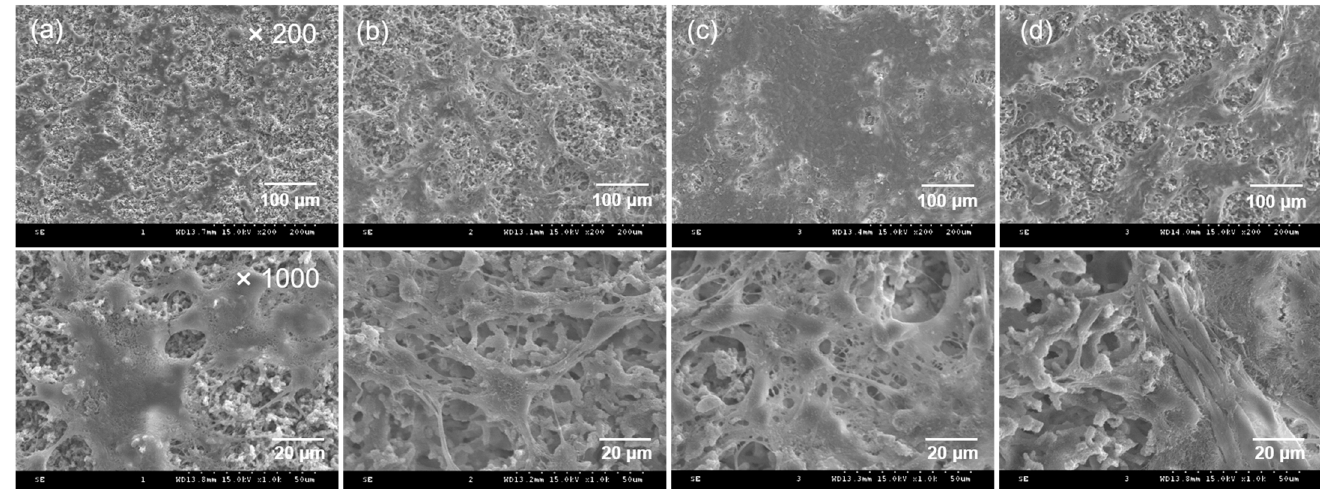
Figure 5. SEM images of cell growth on ( a ) CE, ( b ) CEPP10, ( c ) CEPP20, and ( d ) CEPP50 monoliths after culturing for 5 days plus laser